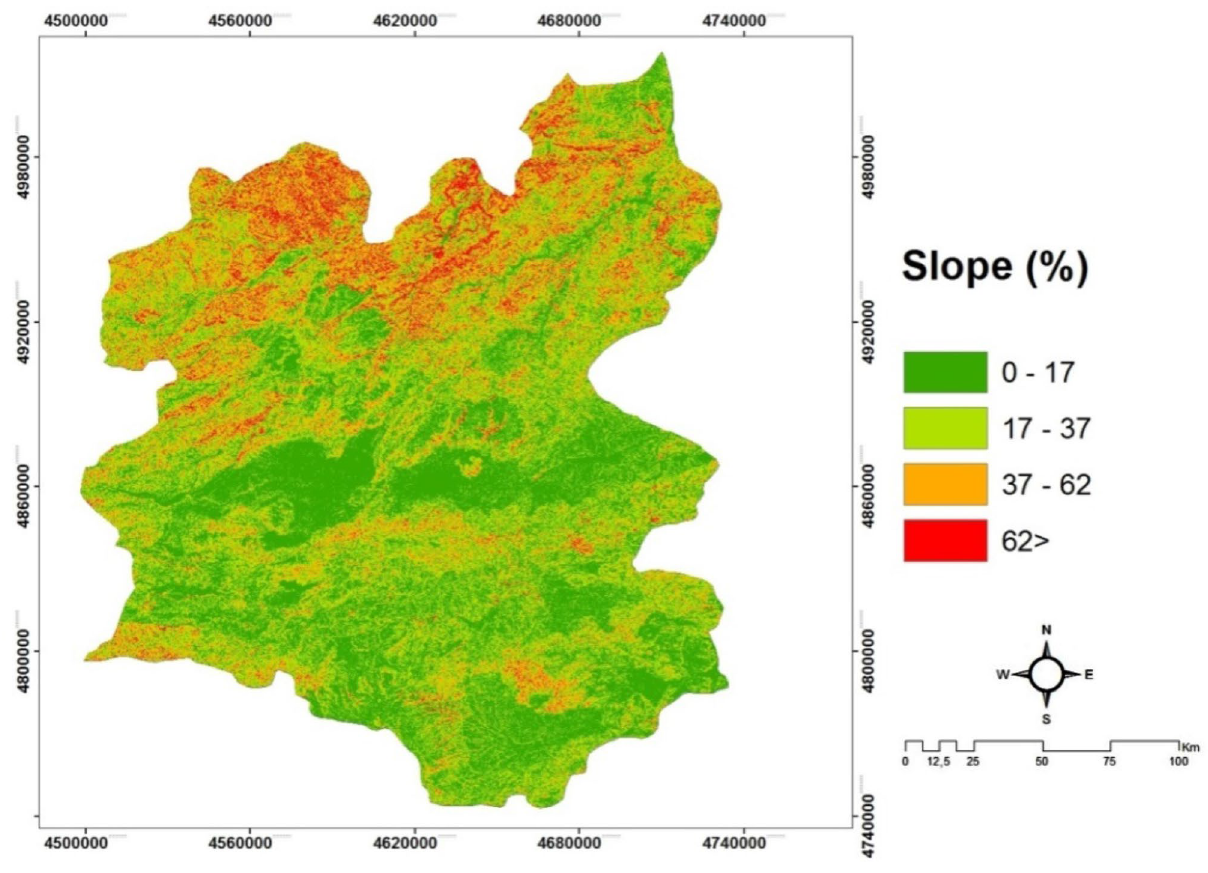
Figure 3. The slope map of